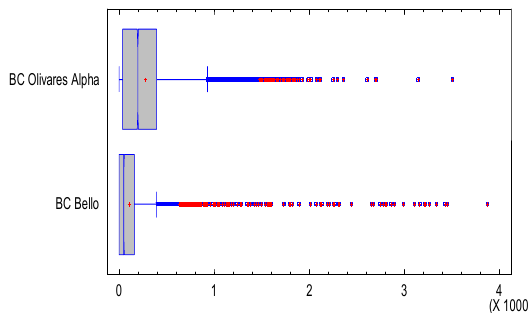
Figure 6. Box and whiskers plot for Black Carbon atmospheric concentration in Olivares Alpha and Bello glaciers.